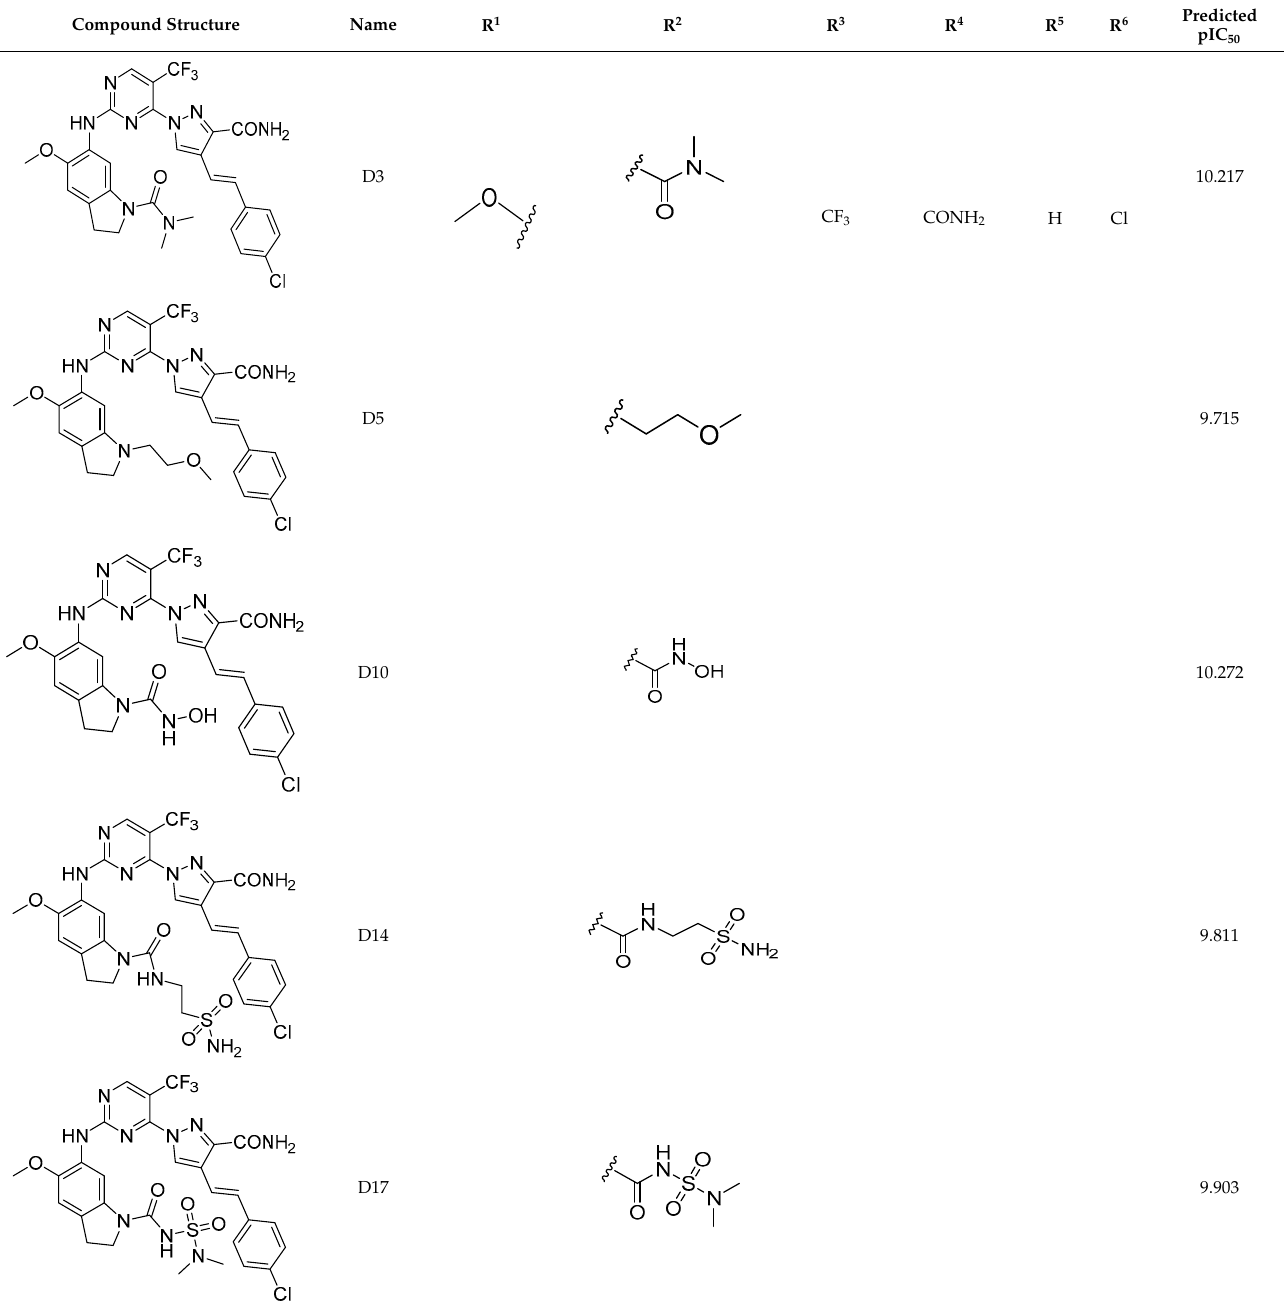
Table 2. The structures and predicted pIC 50 values of few selected designed PLK1 inhibitors.